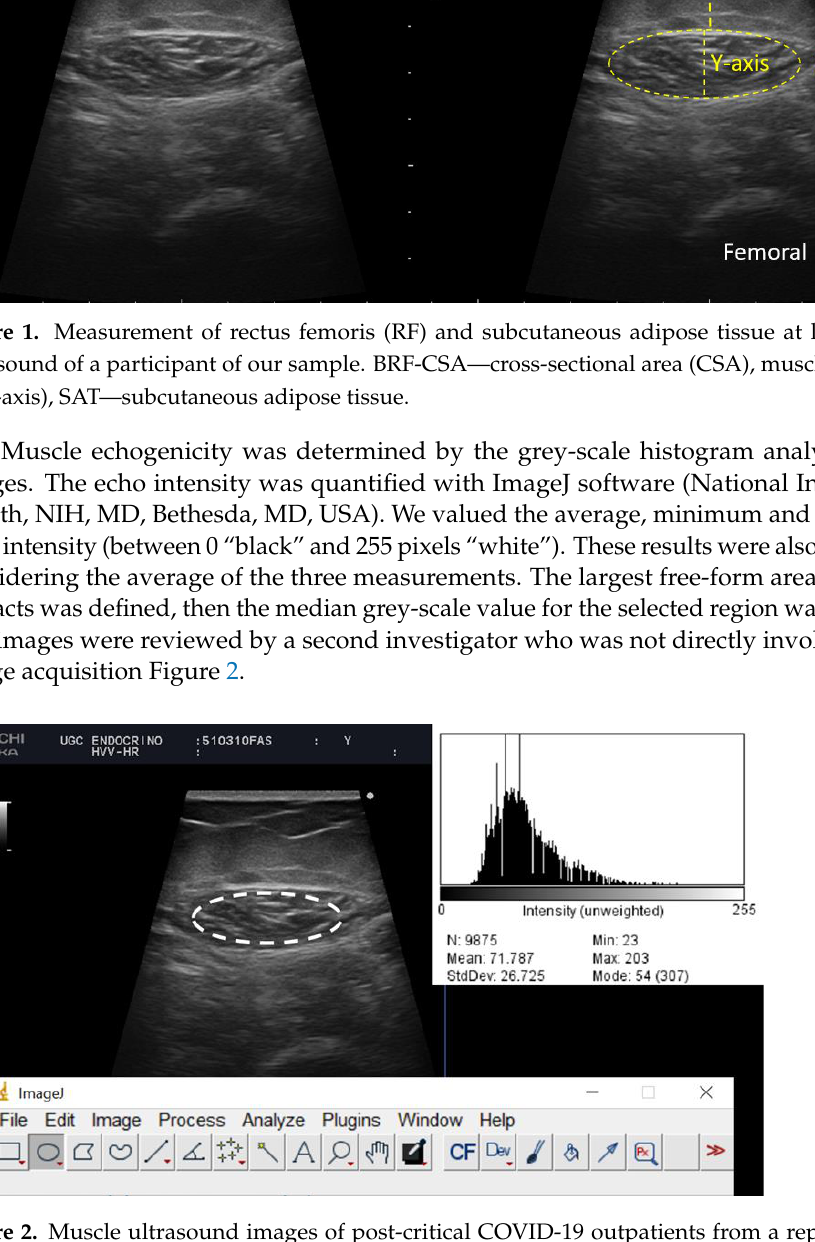
Figure 2. Muscle ultrasound images of post-critical COVID-19 outpatients from a representative patient. The histogram of the echo intensity of the rectus femoris (RF) is shown in the top right corner of the picture. A region of interest (rOI) is selected within the borders of the RF muscle (white line), and the echo intensity is determined using a histogram. Inset is the mean echo intensity of the